Question: Compose a caption that would accompany this figure in a paper.
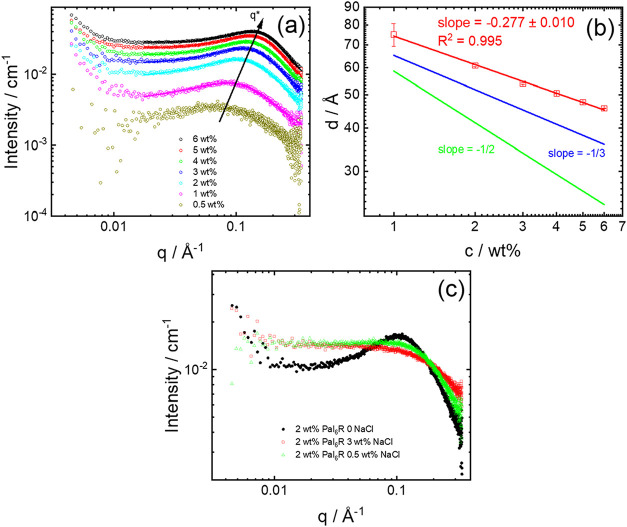
Answer: (a) Open symbols – SAXS data for Pal 6 R at native pH 2.4 at the concentrations indicated. For ease of visualization, only every 3rd data point is plotted. The lines at high q are peak fits used to determine q * using a Lorentzian function with sloping background. (b) Log–log plot showing power-law dependence of characteristic domain spacing d = 2π/ q * on concentration with fitted slope, in comparison to other scaling laws discussed in the text. (c) Data for 2 wt % Pal6R in the absence and presence of salt at the concentrations indicated (3 wt % NaCl is equivalent to 0.6 M). For ease of visualization, only every 3rd data point is shown.